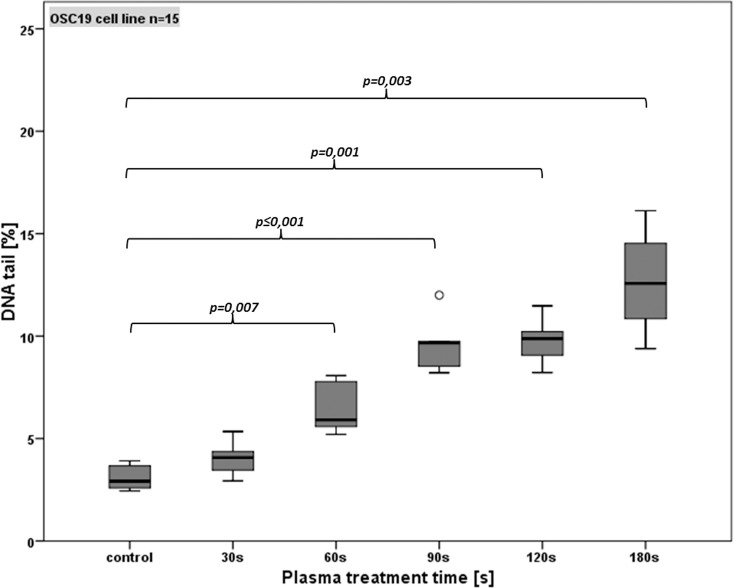
Detection of DNA damage (using the comet assay) in OSC-19 cells after different CAP treatment times.Standard box-plots (lower quartile, median, upper quartile) were used to illustrate the results. Dots denote mild statistical outliers (between 1.5 and 3 times interquartile range (IQR)).